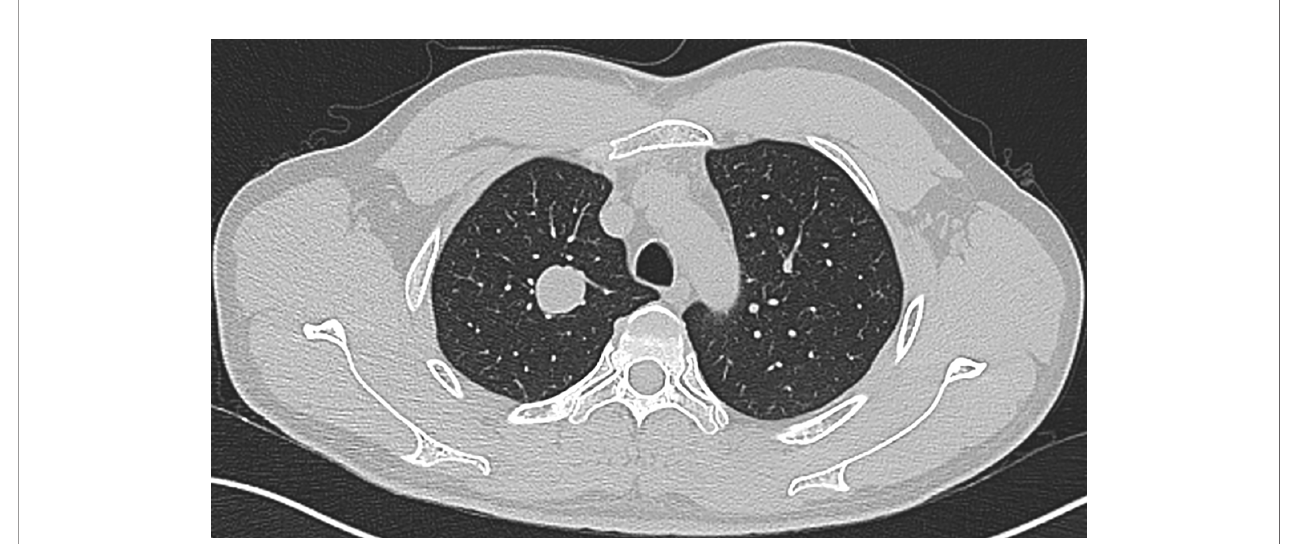
FIGURE 1 | CT scanning of a case shows the lesion closely related to segmental